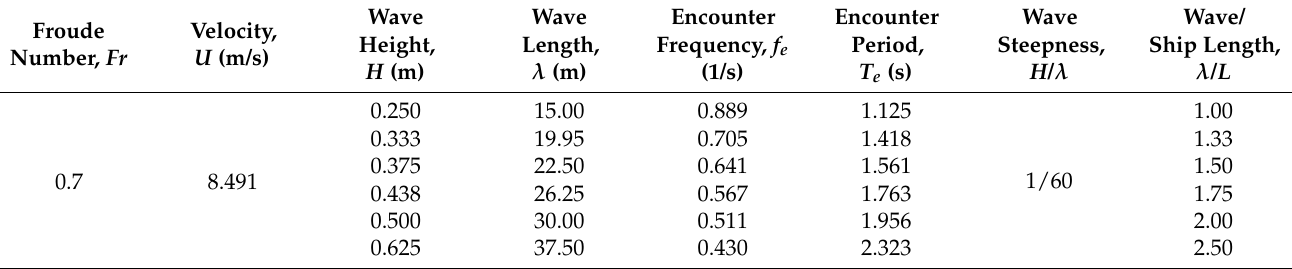
Table 3. Regular wave computations of Double-M craft: test